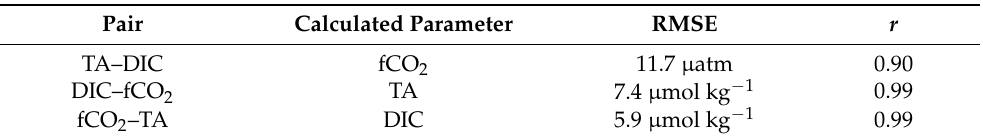
Table 1. Statistics of the calculation of a carbon parameter from a given pair of parameters given by the Root Mean Squared Error (RMSE) and the correlation coefficient ( r ) between the calculated and the 119 measured values.